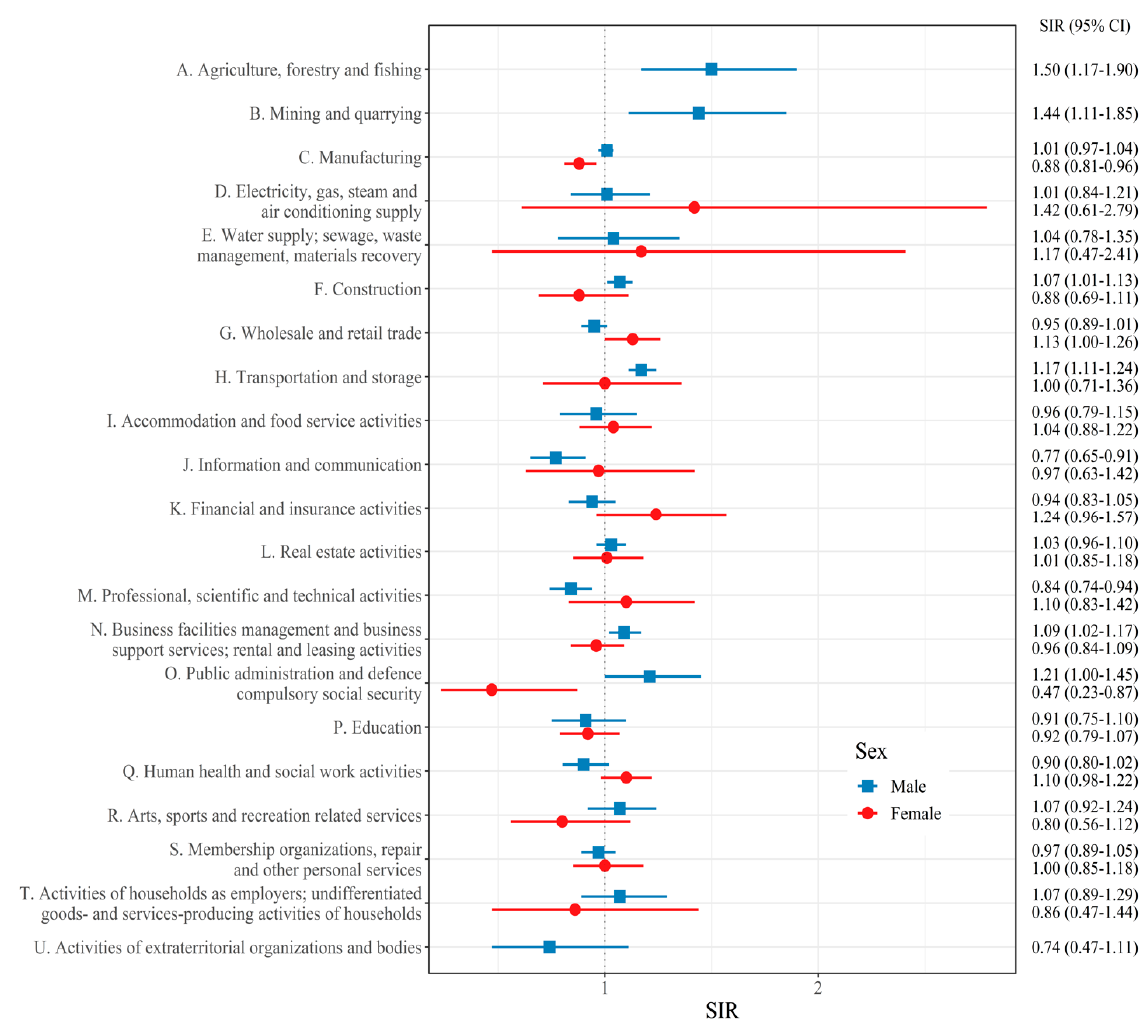
Figure 2. Standardized incidence ratio (SIR) and confidence intervals (CIs) of lung cancer for each industry section. Table 4. Industry groups with a significantly higher risk of lung